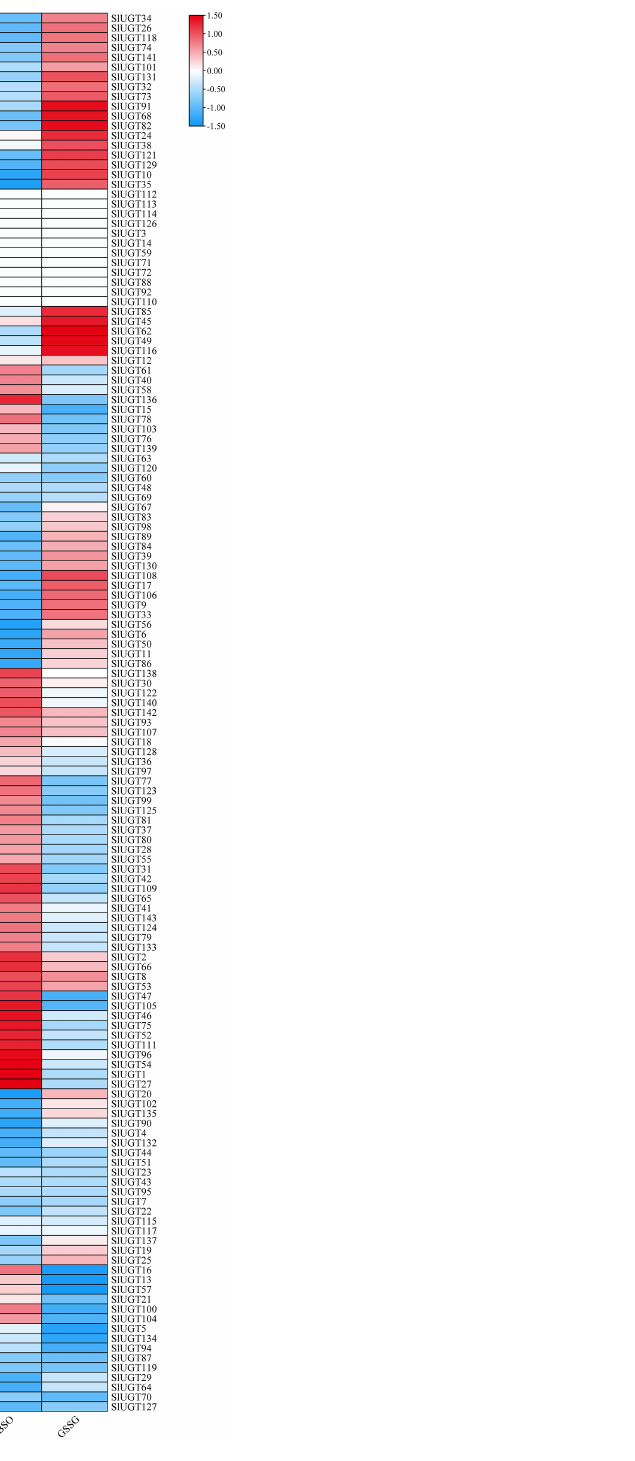
FIGURE 10 | Expression profile of SlUGT genes in transcriptome data under different treatments. All gene expression levels were log scaled by